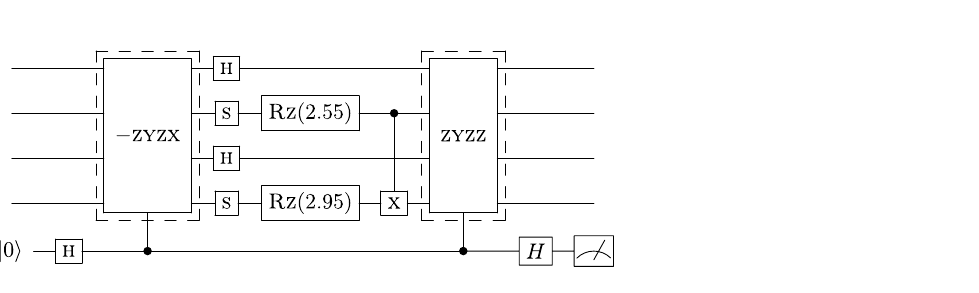
Figure 8. Final error-mitigated circuit for the example described in Fig.